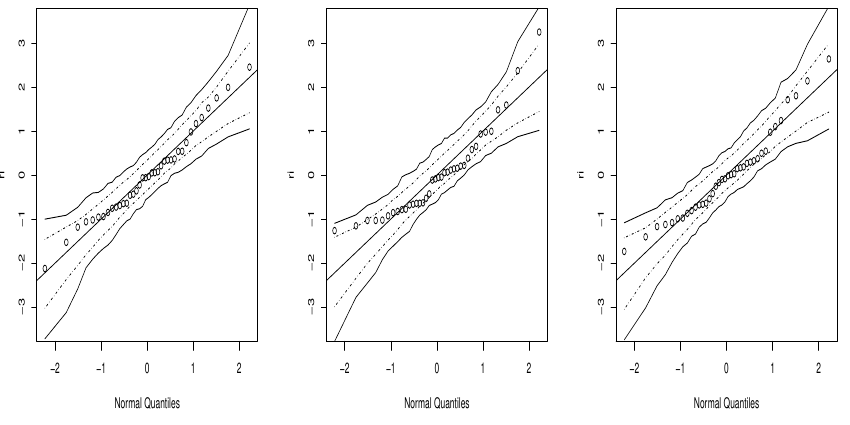
Figure 19. QQ plots of the rqrs: ( left ) QLEP, ( middle ) Kumaraswamy an ( right )